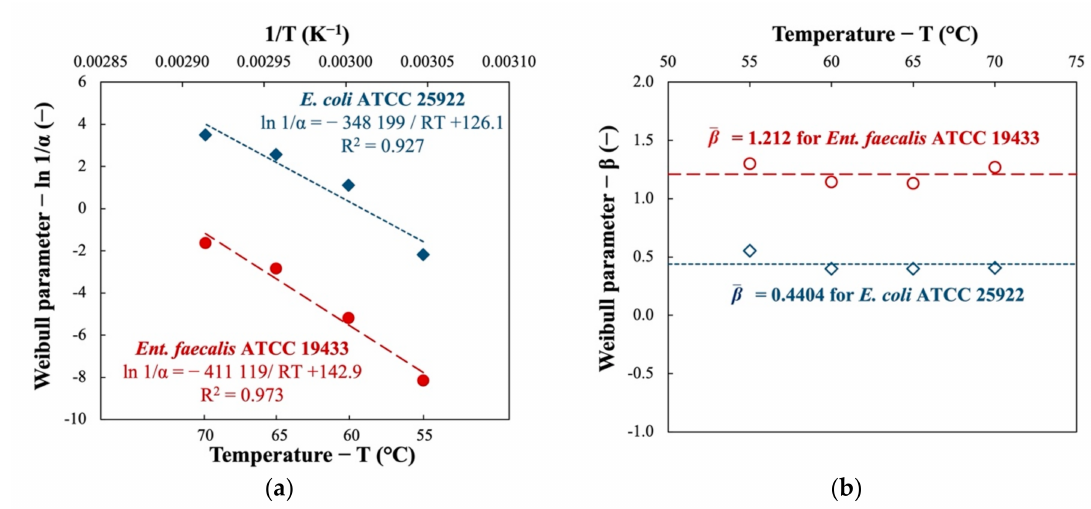
Figure 2. Dependence of ( a ) Weibull scale parameter α and ( b ) Weibull shape parameter β on the treatment temperature during thermal pasteurization of two indicator bacteria in nutrient